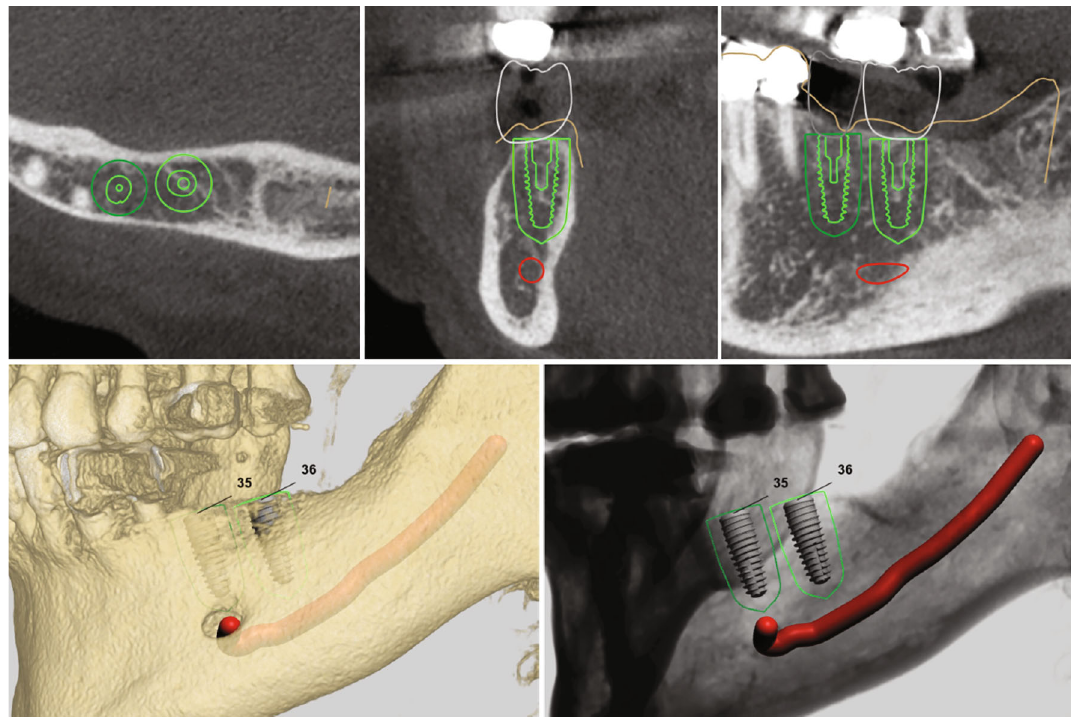
Figure 3: Screenshot from the guided surgery